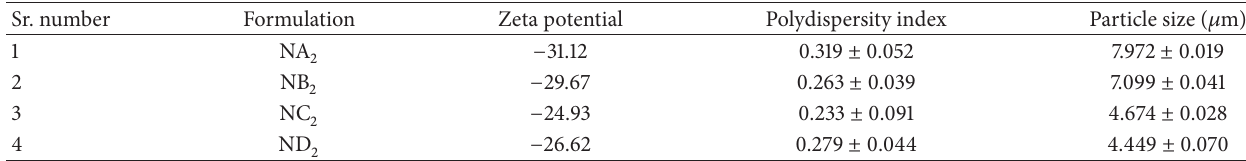
Table 3: Zeta potential and polydispersity